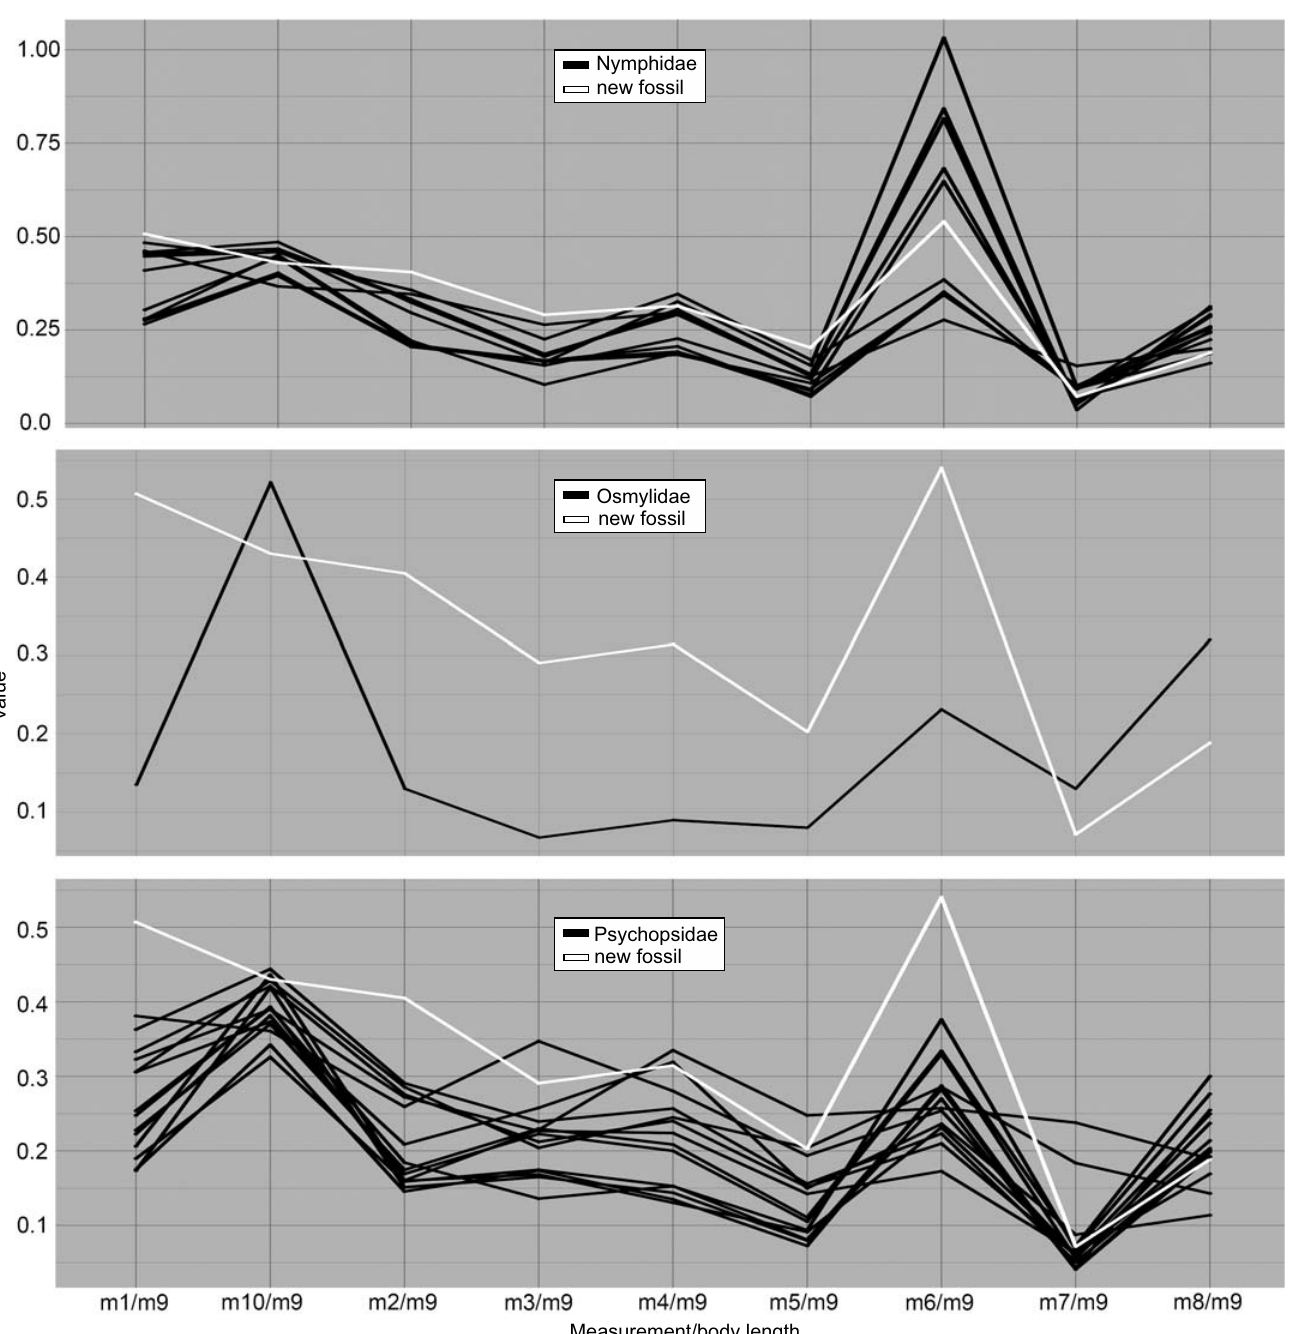
Fig. 7. Parallel coordinates plot for larvae of Nymphidae (split-footed lacewings), Osmylidae (lance lacewings), and Psychopsidae (silky lacewings). White line represents MfN MB.I